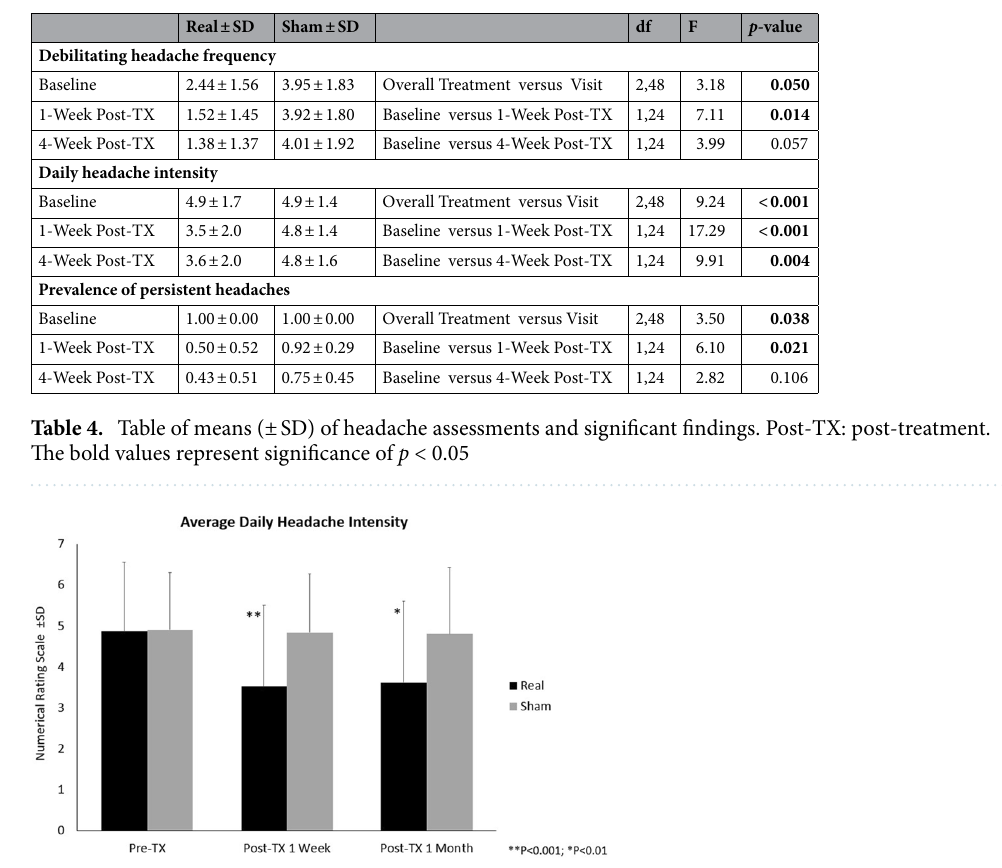
Figure 5. Average Daily Headache Intensity. Pre-Tx: Pre-treatment; Post-Tx: Post-treatment; ** P < 0.001; * P < 0.01. Analysis was conducted using SPSS version